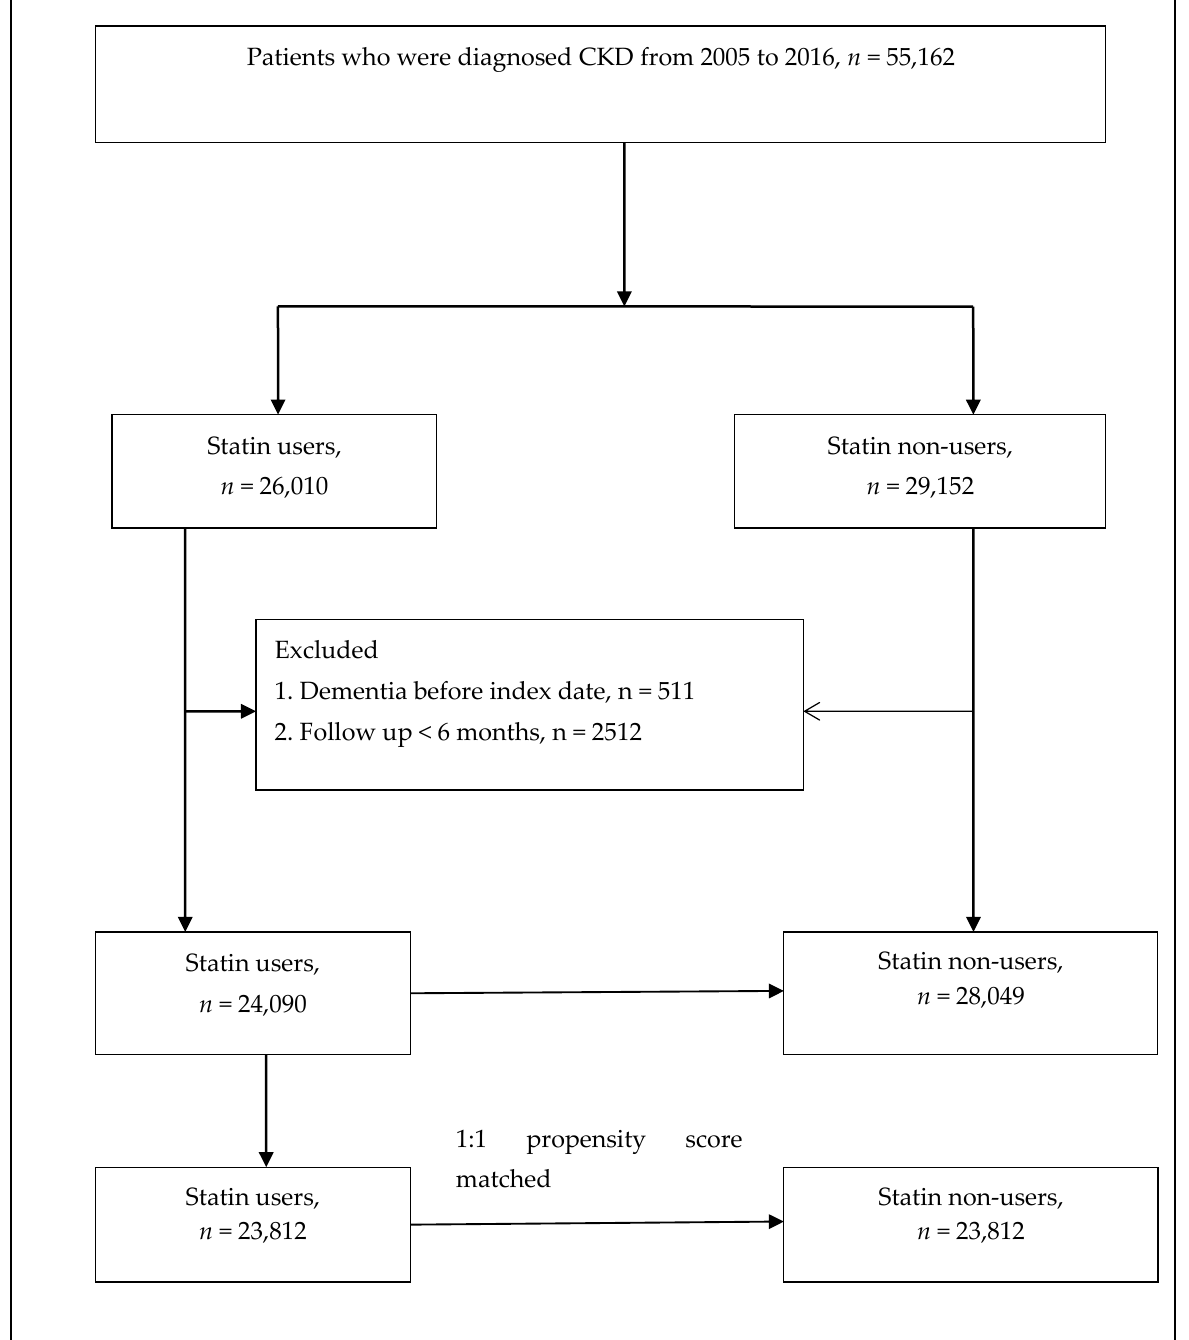
Figure 1. Patient flow chart.